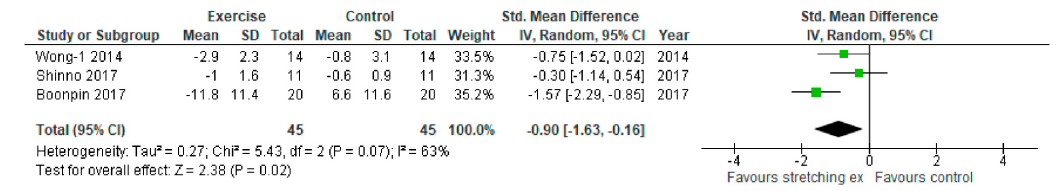
Figure 3. Sensitivity analysis with only RCTs comparing changes in arterial stiffness following stretching exercises to non-exercise controls (sensitivity analysis-1 for primary outcome). SD, standard deviation; IV, inverse variance; CI, confidence interval; Std, standardized.